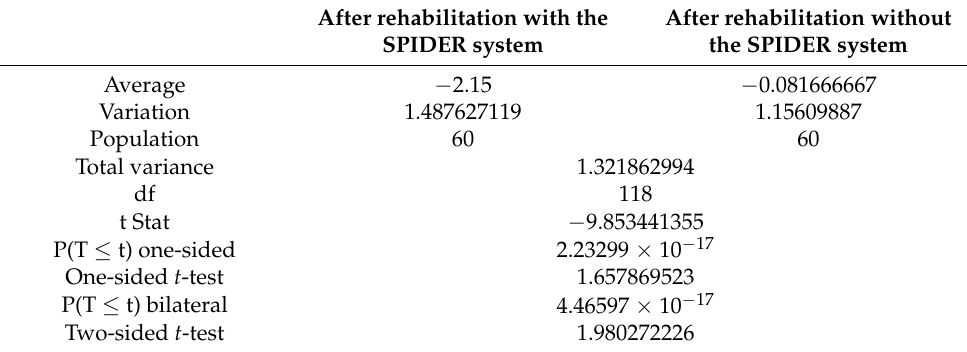
Table 6. The results of the statistical analysis of the average tilt after rehabilitation with and without the SPIDER system.